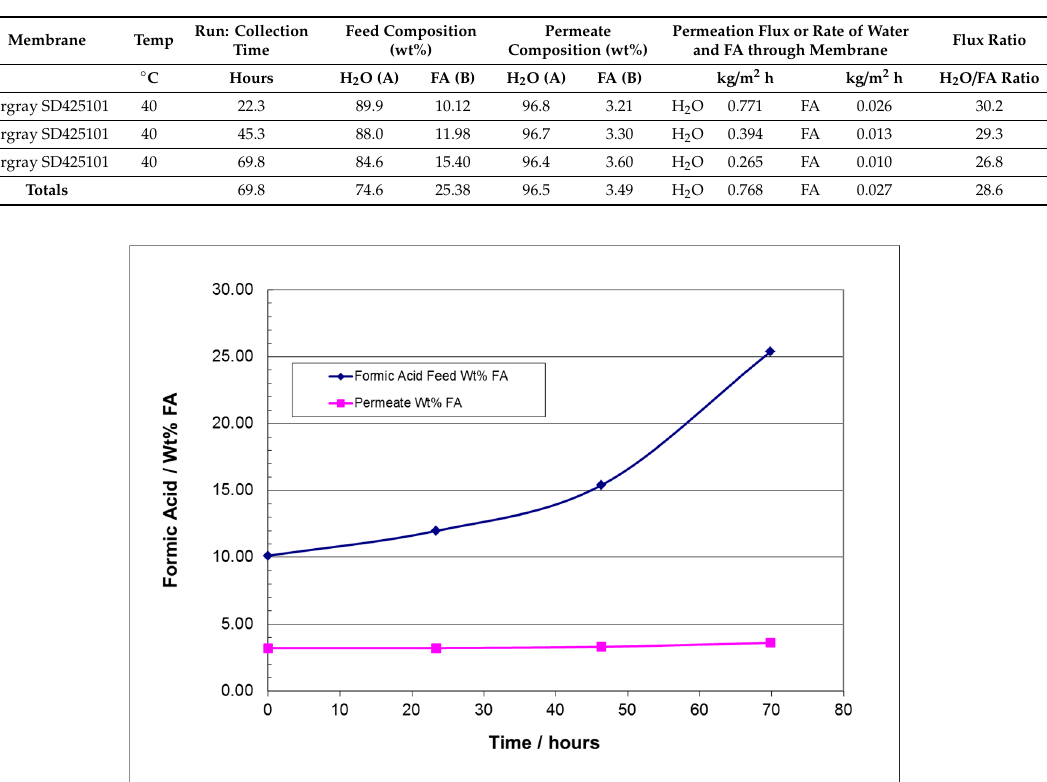
Figure 6. Extended time batch pervaporation cell test run at 40 °C over a period of 69.84 h using a Targray SD425101 membrane, starting 10.12 wt% FA feed solution. The FA feed solution increased to about 25.38 wt% with a final composite permeate FA composite concentration of 3.49